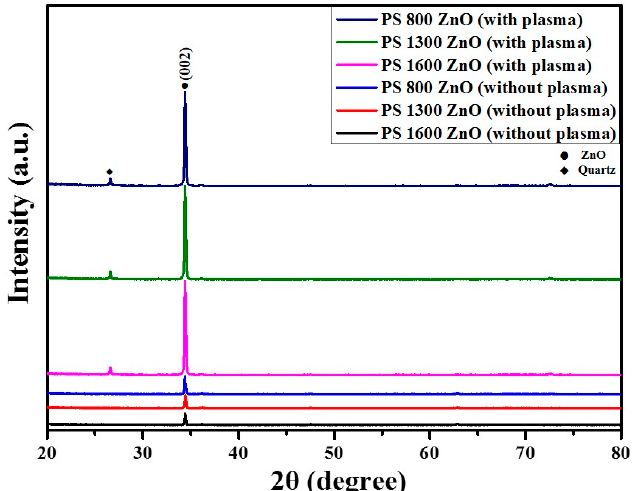
Figure 2. X-ray diffraction pattern of ZnO nanorod–assisted PS sphere monolayer arrays grown on a quartz substrate (with and without oxygen plasma treatment).